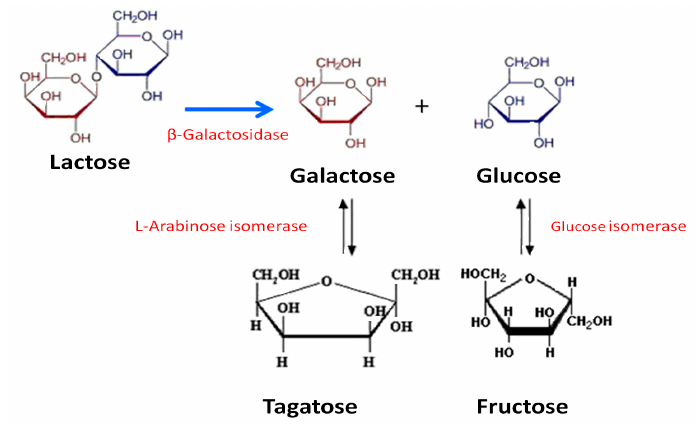
Figure 1. Diagram of reactions for enzymatic production of ketohexoses from lactose. Structures of main products of interest are depicted with enlarged sizes.